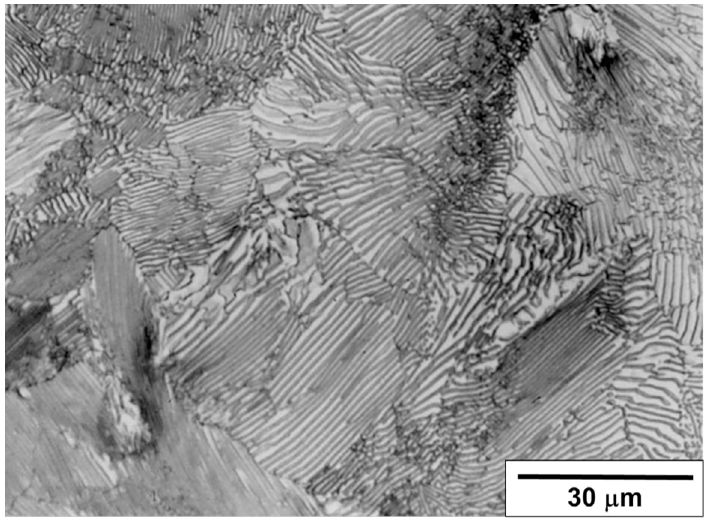
Figure 3. Fine Pearlite Observed in the Annealed AISI 4140 Steel Alloy (Sodium Bisulfate etch).